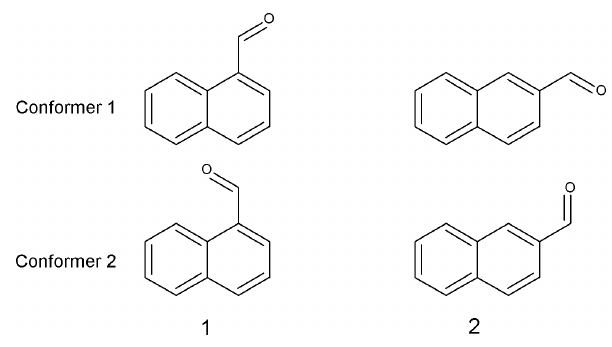
Figure 5. Two conformers of 1-napthaldehyde (1) and 2- napthaldehyde